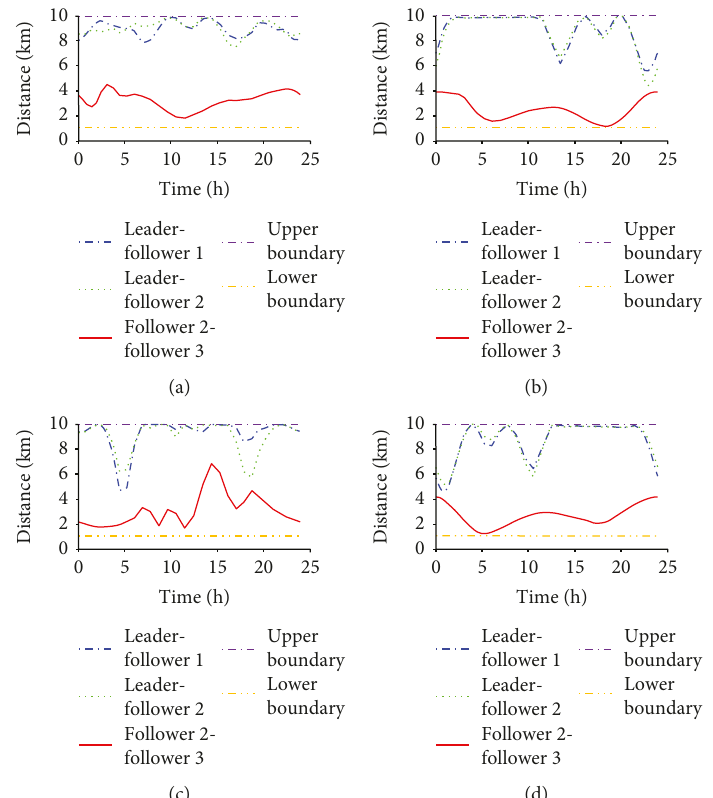
Figure 8: Loosely formation with station-keeping box: the relative distance of hybrid sail on (a) winter solstice, (b) spring equinox, (c) summer solstice, and (d) autumn equinox in the frame (A).